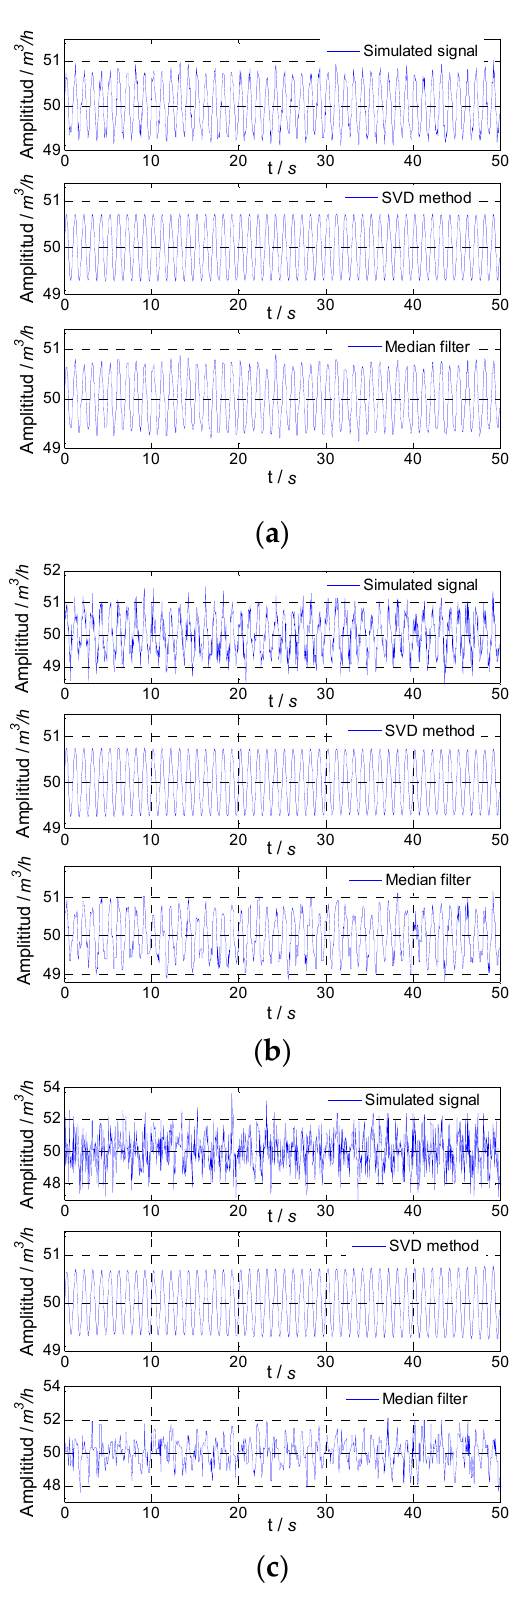
Figure 3. Simulated result for 1 Hz signal: ( a ) noise variance, 0.01; ( b ) noise variance, 0.1; ( c ) noise variance, 1.